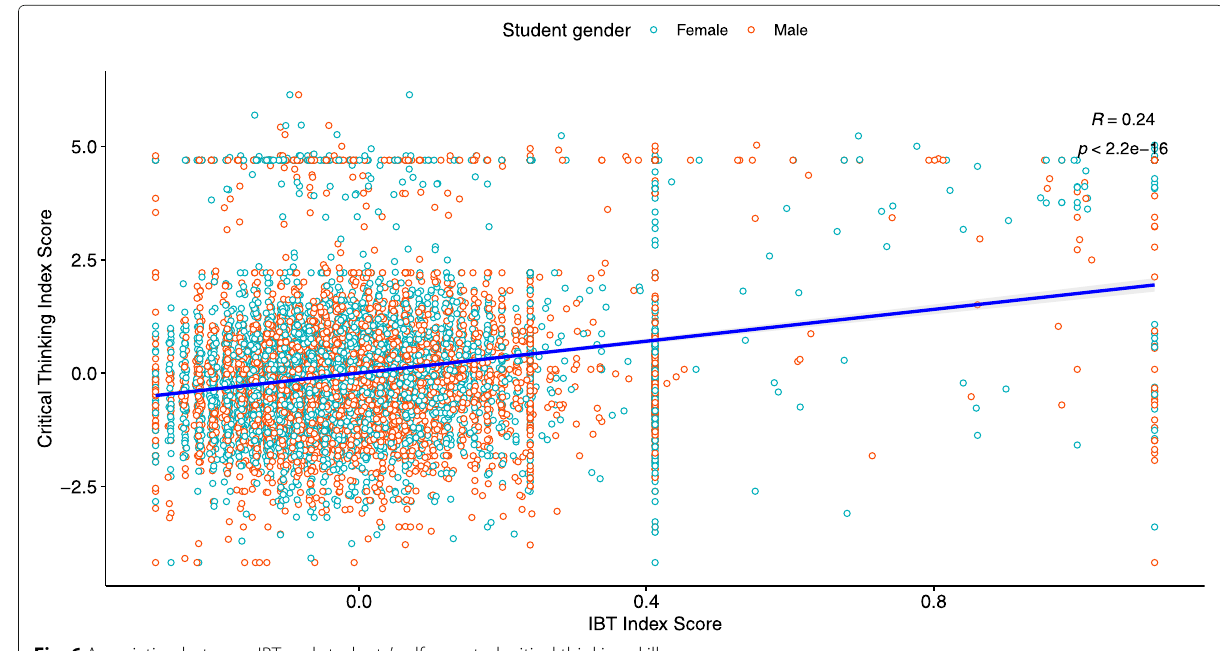
Fig. 6 Association between IBT and students’ self-reported critical thinking